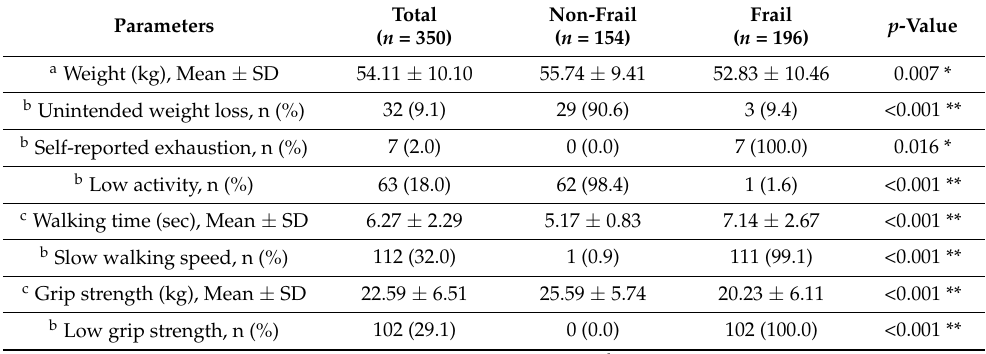
Table 2. Comparison of physical frailty indicators between non-frail and frail older